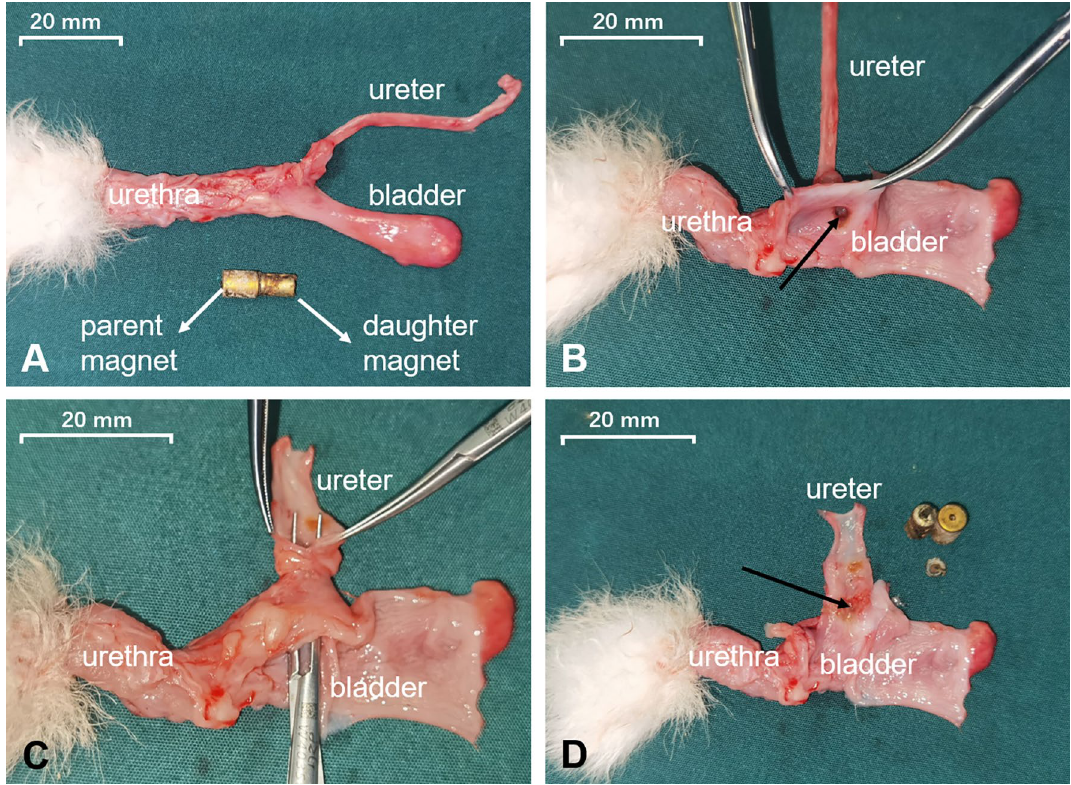
Figure 5. Gross specimens of ureterovesical anastomosis. ( A ) General view of the ureterovesical anastomosis. ( B ) Anastomosis on the side of the ureter. ( C ) Anastomosis on the side of the bladder. ( D ) Section view of the ureterovesical